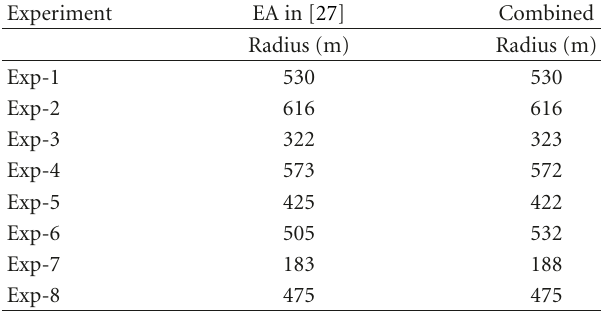
Table 11: Result comparison between the combined algorithm and the EAP in